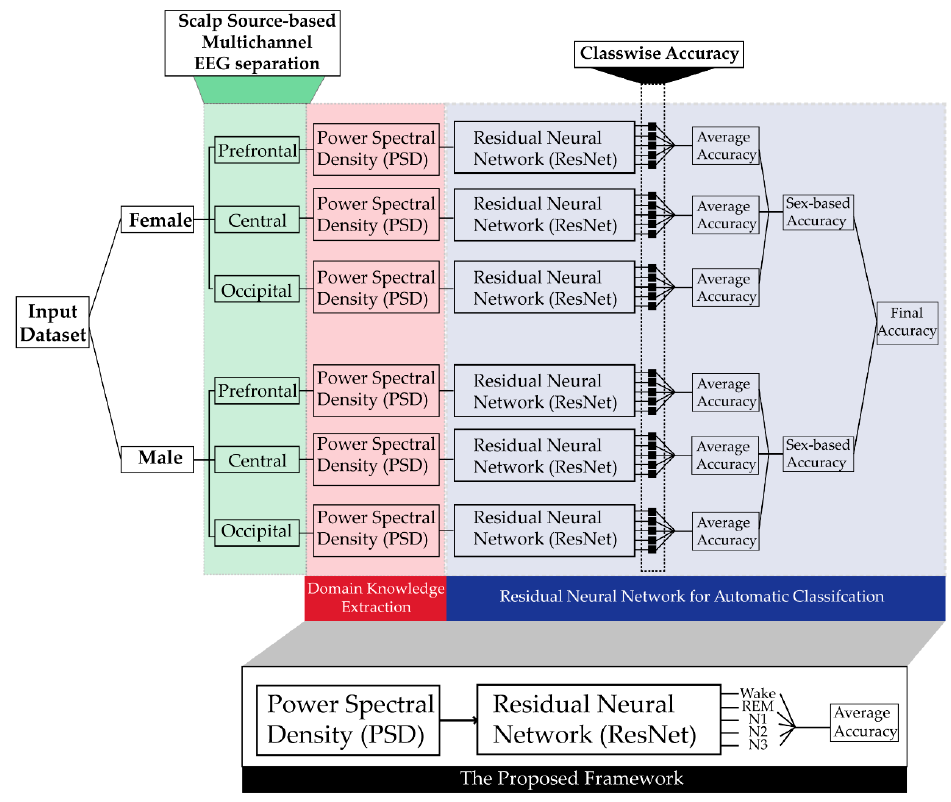
Figure 1. Block diagram of the proposed method.